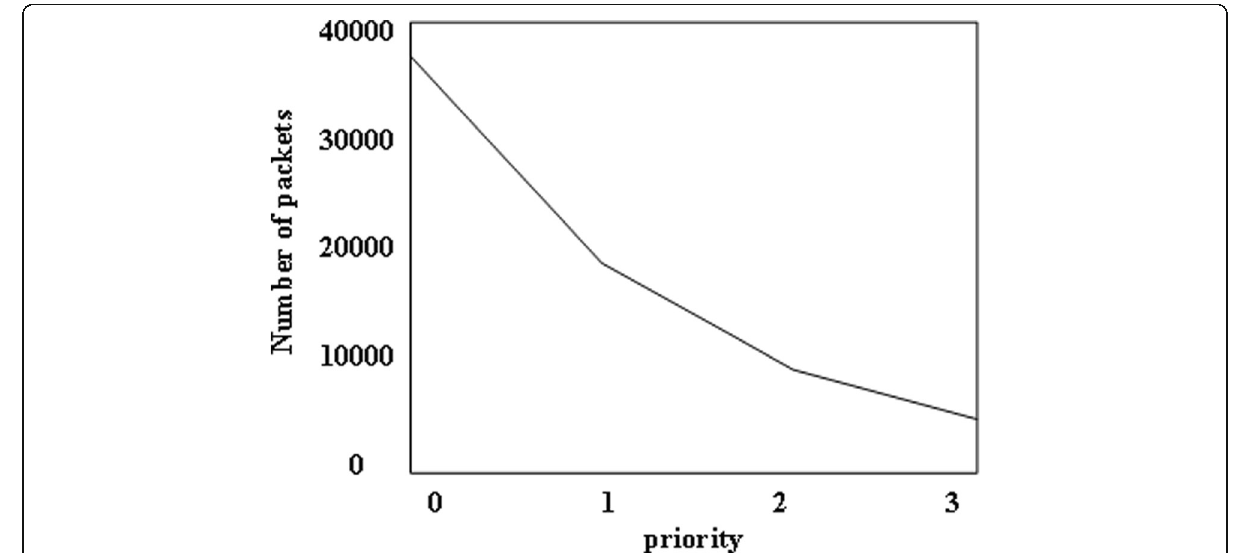
Fig. 3 Number of packets with different priorities on